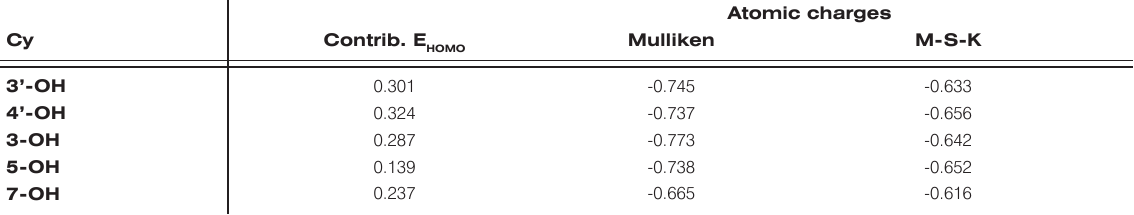
Table 5. Contributions to the E and atomic charges of the O atoms of the cyanidin hydroxyl groups (HF/6-31+G(2d,p) level). HOMO